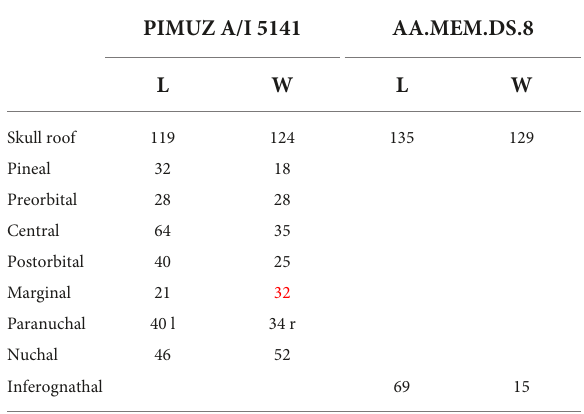
( Figure 7F ) and PIMUZ A/I 4773, with a dorsal lobe longer than the ventral one. In the holotype AA.MEM.DS.8, the dorsal lobe is about 220 mm long, tapering distally, where it ends in a rounded lobe. The ventral lobe also has a rounded end but is shorter, 160 mm